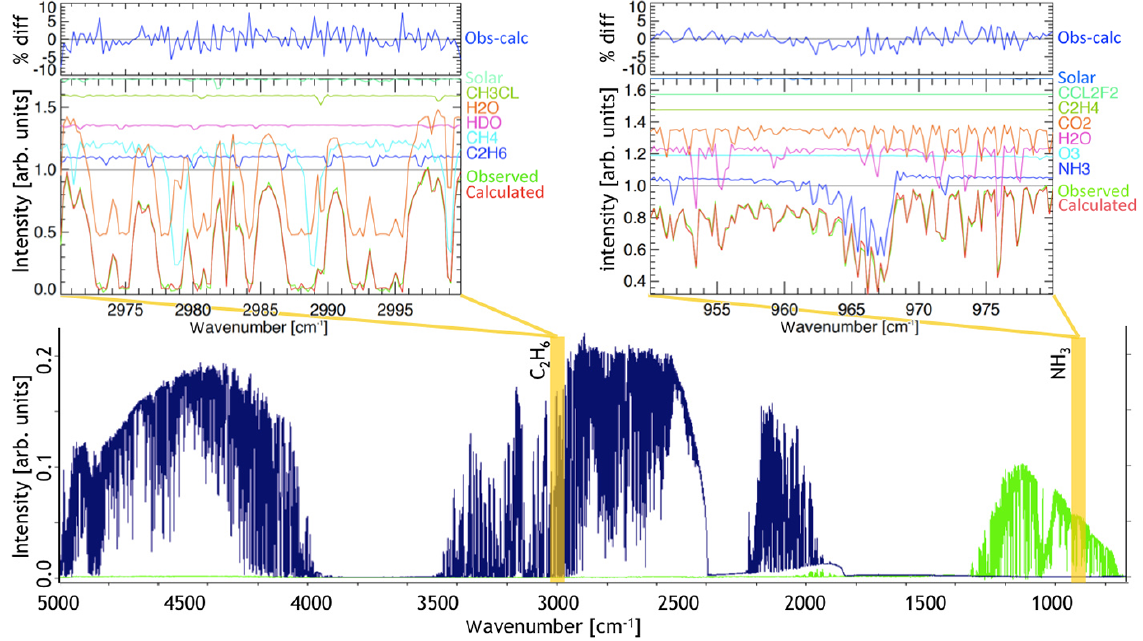
Figure 2. Solar spectrum measured by the InSb (blue) and MCT (green) detectors. Yellow bars indicate the spectral intervals used for the retrieval of C 2 H 6 and NH 3 . Spectral proof of C 2 H 6 is shown on the top left and of NH 3 on the top right. The C 2 H 6 column was